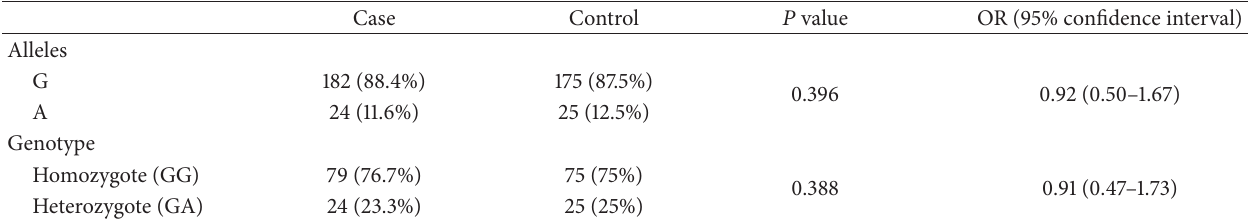
Table 2: Distribution of allele and genotype of CCR2 gene polymorphism in the case and control